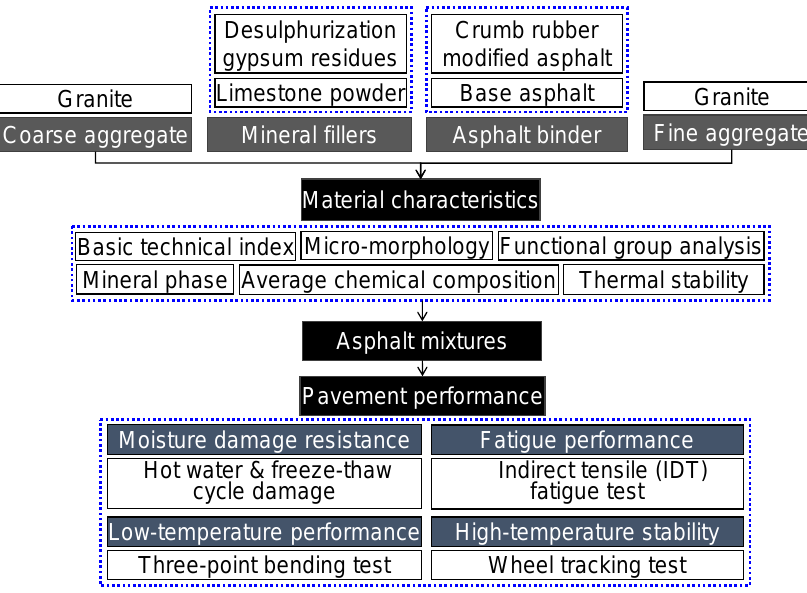
Figure 1. Research flow chart of this research.